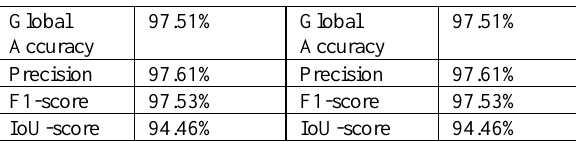
Table 2 . Statistics of the semantic segmentation on the test set.